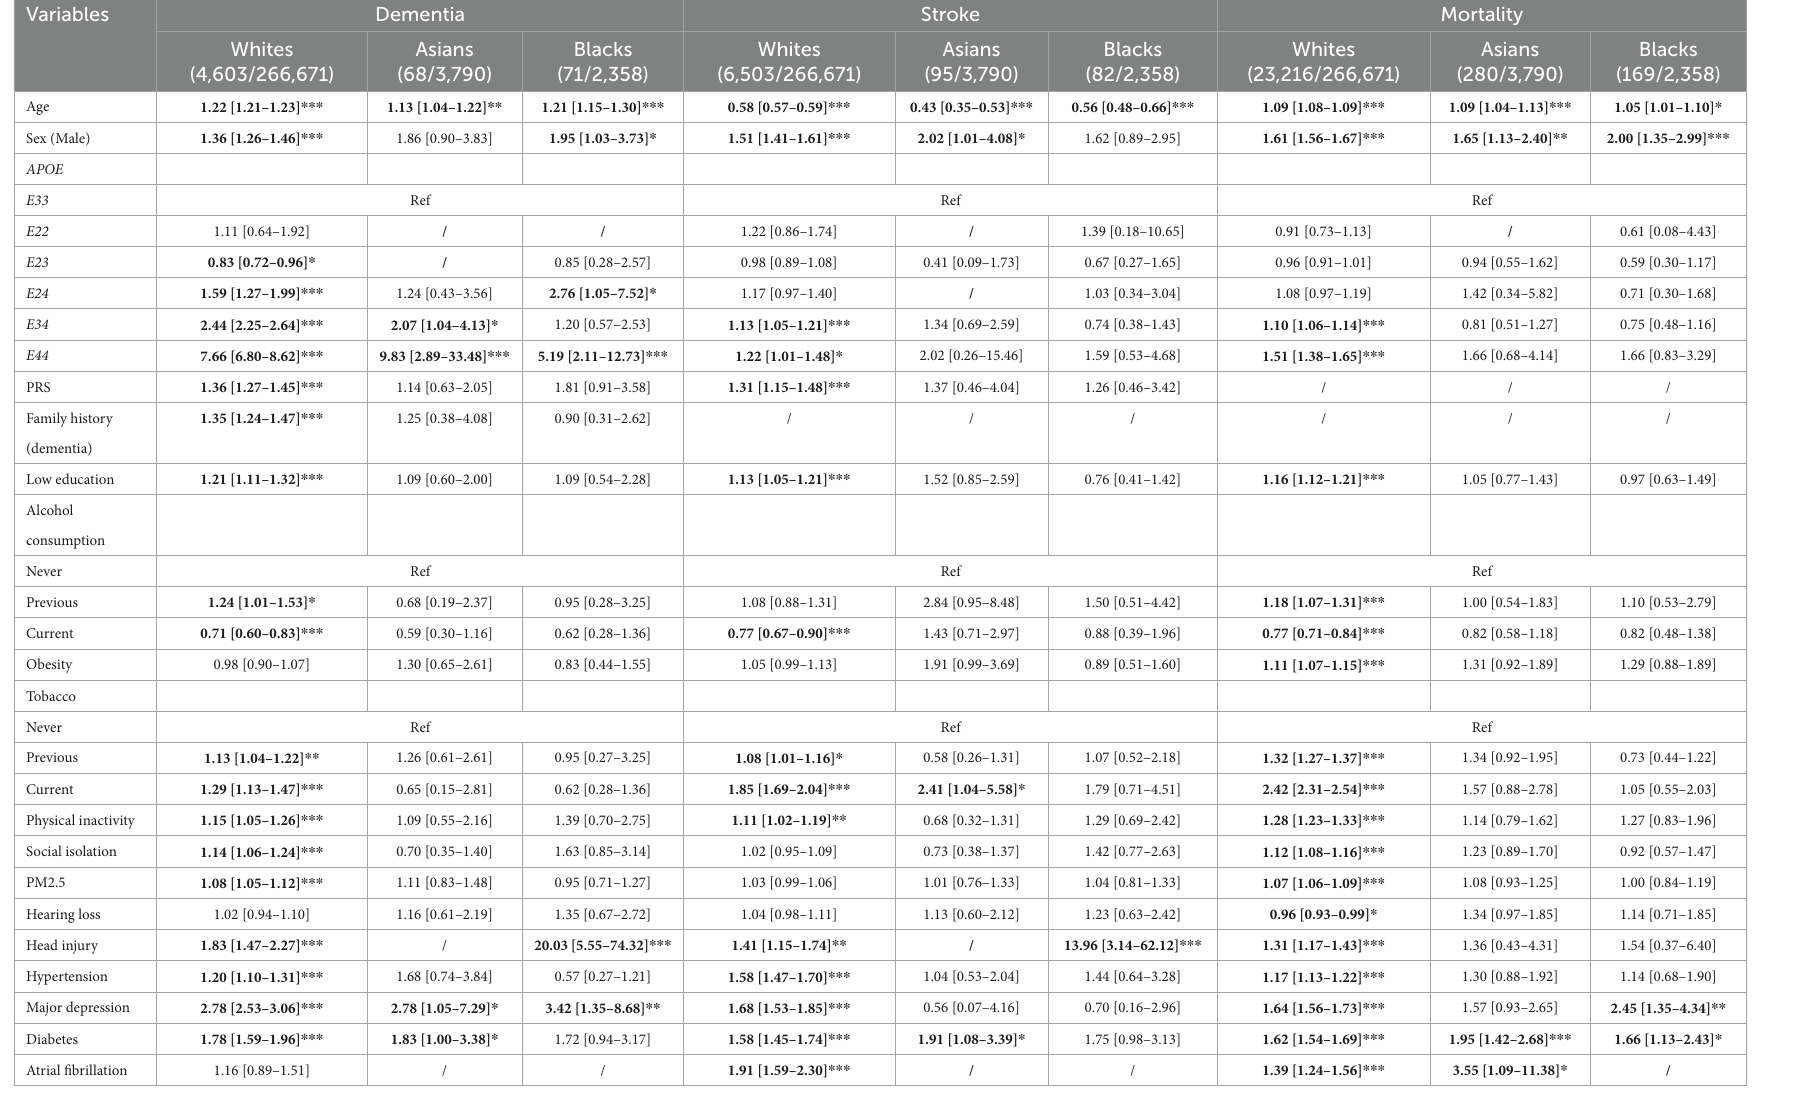
TABLE 2 Results of the multivariate